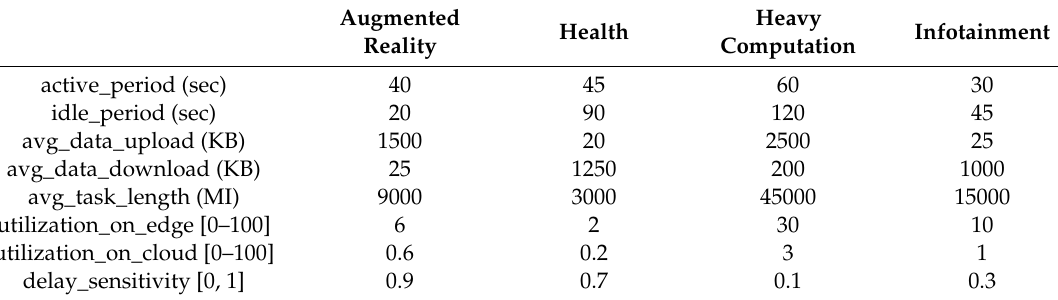
Table 1. Application parameter setting in the